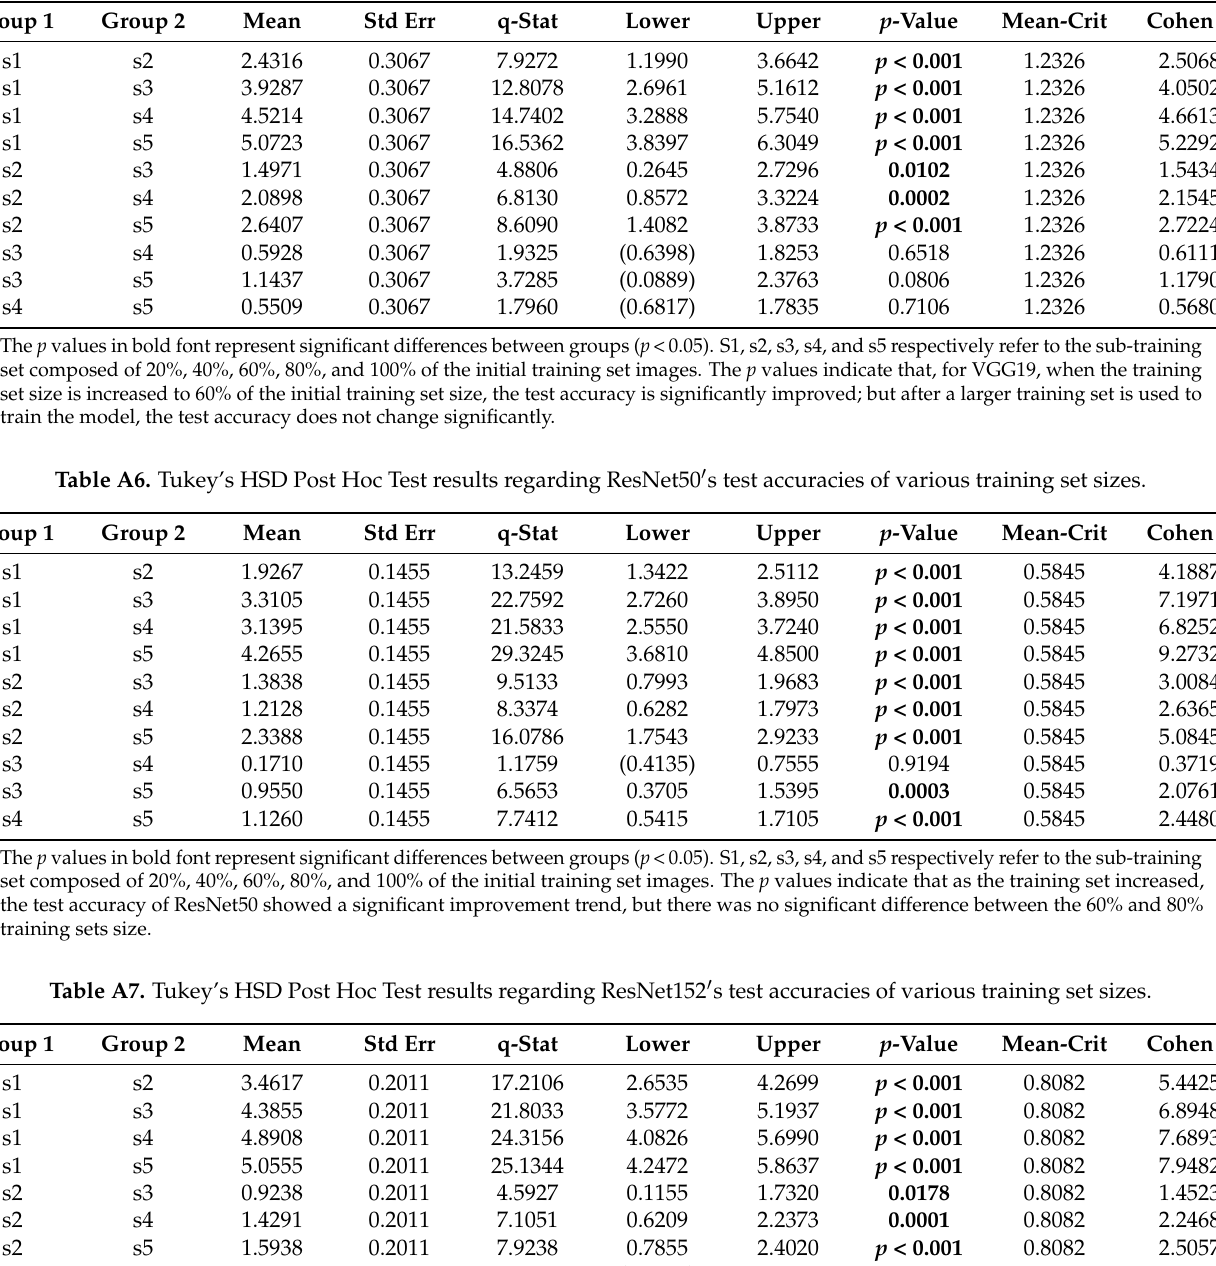
Table A5. Tukey’s HSD Post Hoc Test results regarding VGG19 (cid:48) s test accuracies of various training set sizes.